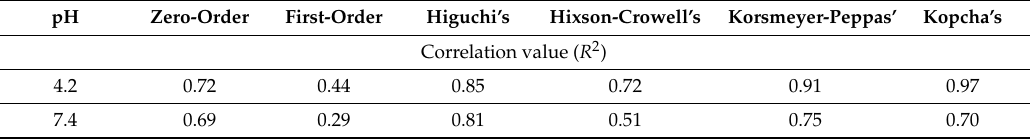
Table 5. Correlation co-e ffi cient ( R 2 ) obtained from modelling 5-FU loaded 5% PEG-CHIT-MSNs through release kinetic models at pH 7.4 and 4.2.